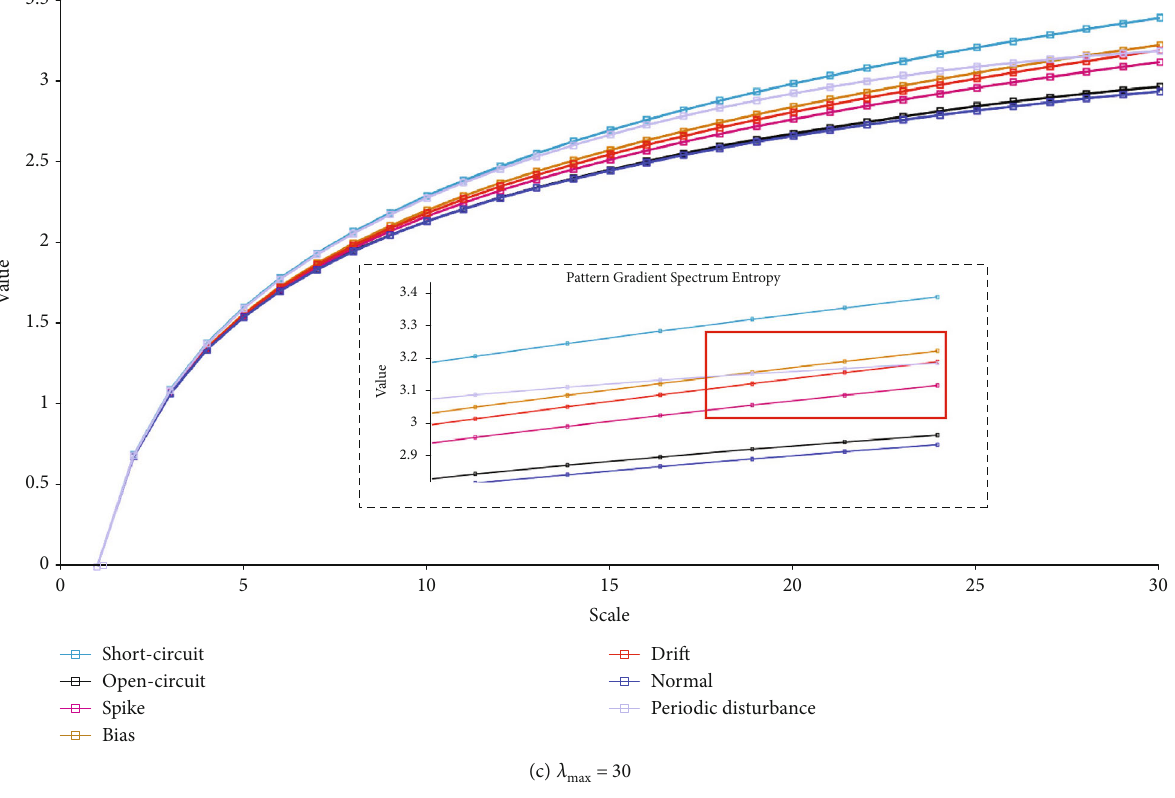
Figure 5: Maximum SE scales with di ff erent values.